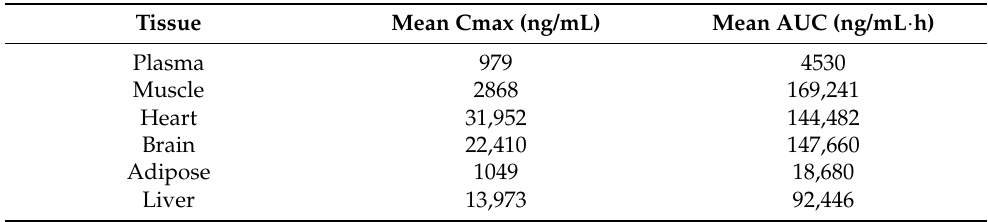
Table 6. PBPK-predicted epirubicin mean Cmax (ng/mL) and mean AUC (ng/mL · h) in tissue and plasma over 168 h after IV injection in a Sim-Cancer